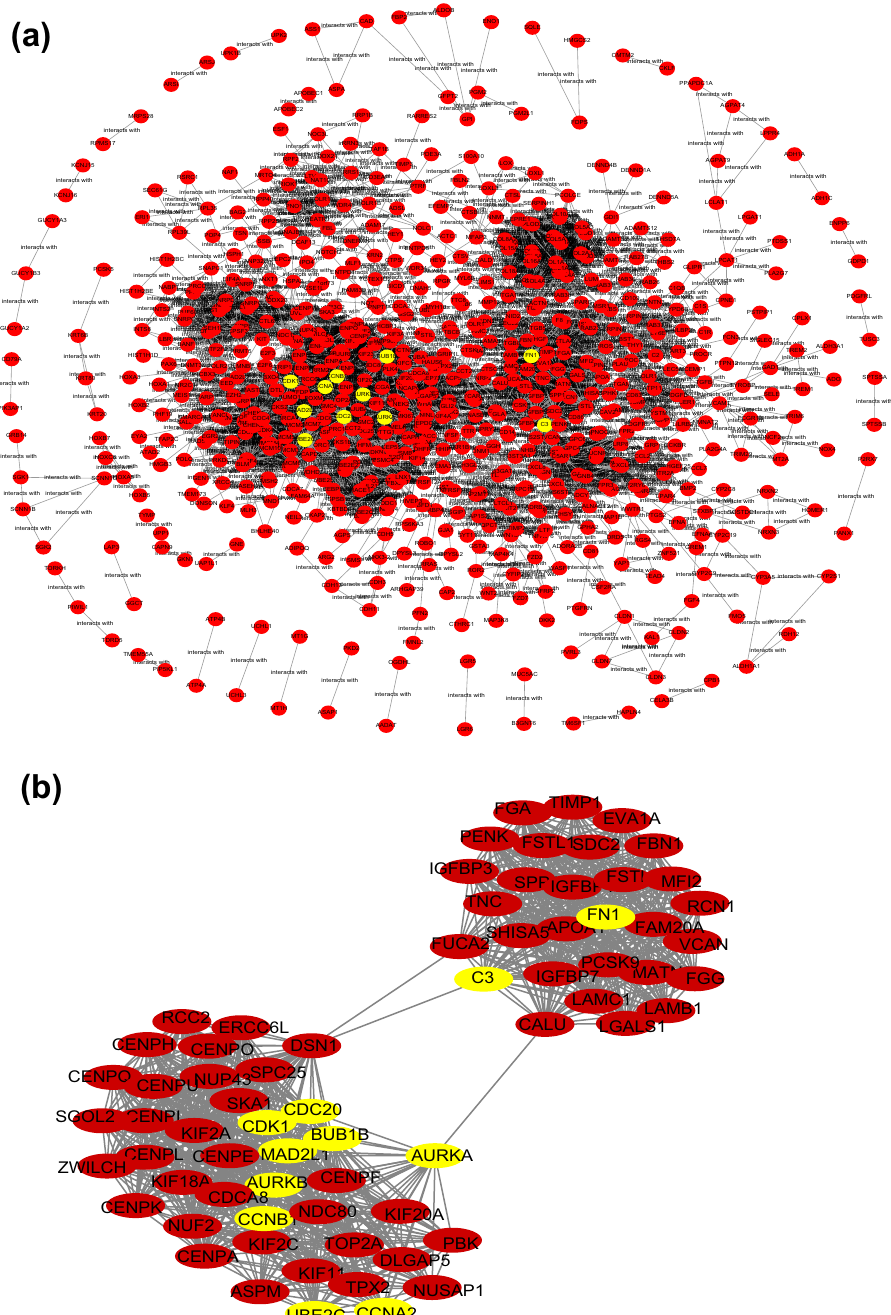
Figure 4. PPI network and highest score clustering module. ( a ) PPI network, yellow color indicates the hub genes, red nodes represent DEGs. ( b ) The highest score clustering module generated by MCODE, yellow color indicates the hub genes, red nodes represent DEGs. [The figures were created by STRING V11.0 (https ://strin g-db.org/) and MCODE plug-in in Cytoscape (https ://cytos